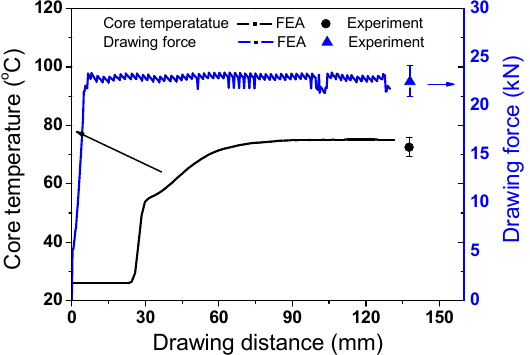
Figure 4. Comparison of core temperature and drawing force between experiment and FEA using low-carbon steel wire rod. Table 2. Comparison of equilibrium drawing force and core temperature between experiment and FEA.